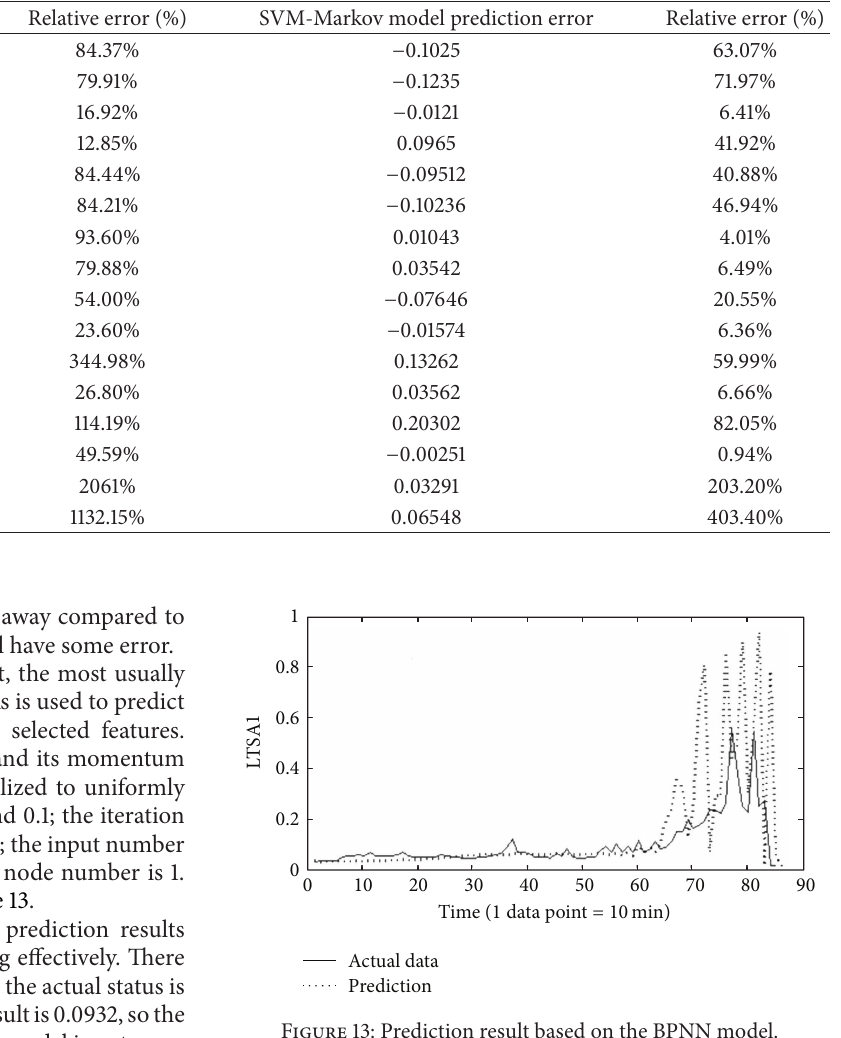
Figure 13: Prediction result based on the BPNN